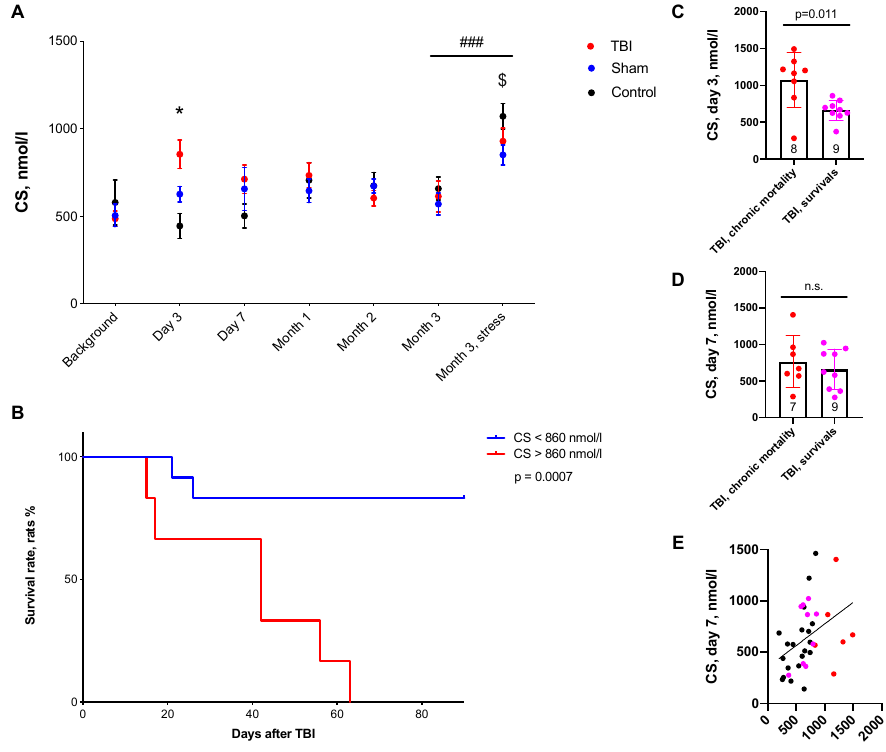
Figure 1. CS time course 3 months after TBI and TBI-induced mortality. ( A )—CS dynamics during the experiment. CS was elevated on day 3 in rats after TBI. After a forced swim test (month 3, stress) CS was elevated in all animals, though it tended to be higher in controls. ( B )—Survival rates in rats with high and low CS levels on day 3 after TBI. Survival rate was lower in rats with CS > 860 nmol/L (Kaplan–Meier method). ( C , D )—CS levels on days 3 and 7 in survived animals and deceased animals, respectively (Wilcoxon test). ( E )—Correlation of CS levels on day 3 and 7 (Spearman correlation, p = 0.007). *— p = 0.007, day 3 after craniotomy, Kruskal–Wallis test, TBI vs. Control, p = 0.011. $— p = 0.090, Kruskal–Wallis test, Sham vs. Control, p = 0.098. ###— p < 0.001, Wilcoxon test, n.s.—not